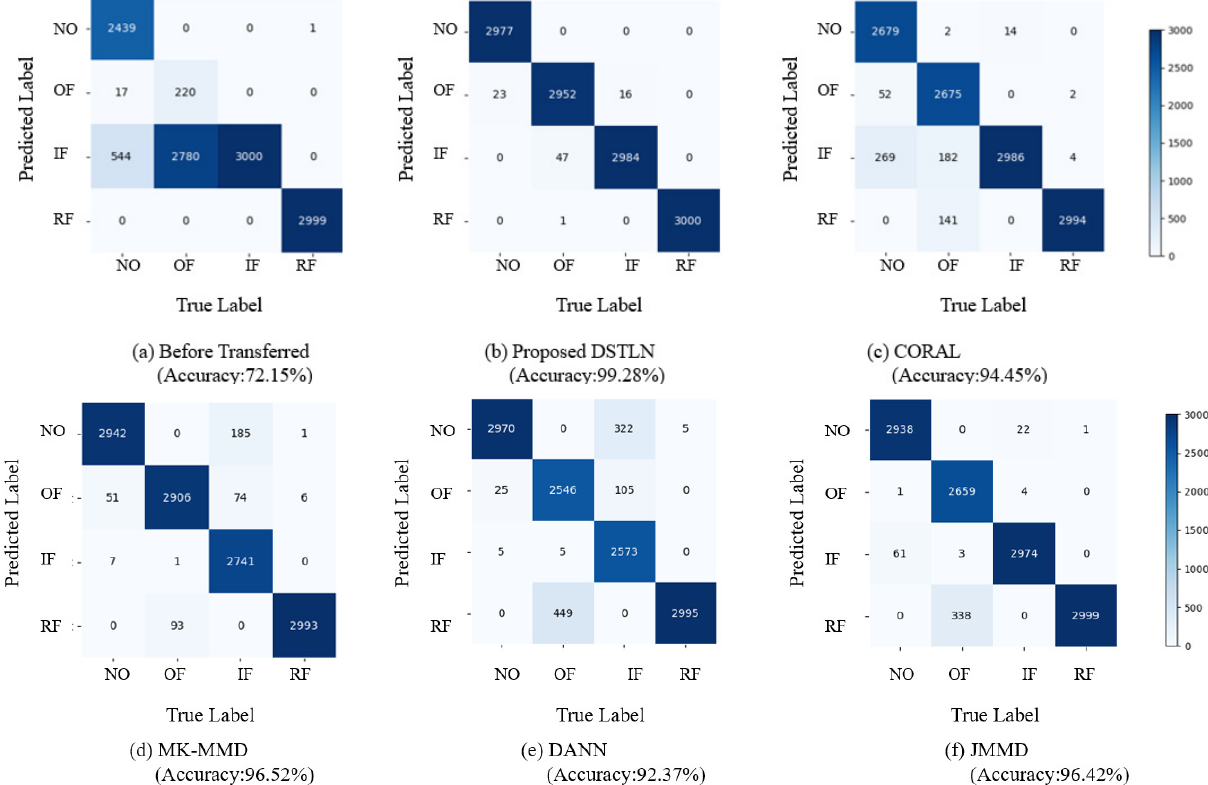
Figure 12. The results between variable speed condition No. 15 and the other 12 constant speed conditions.